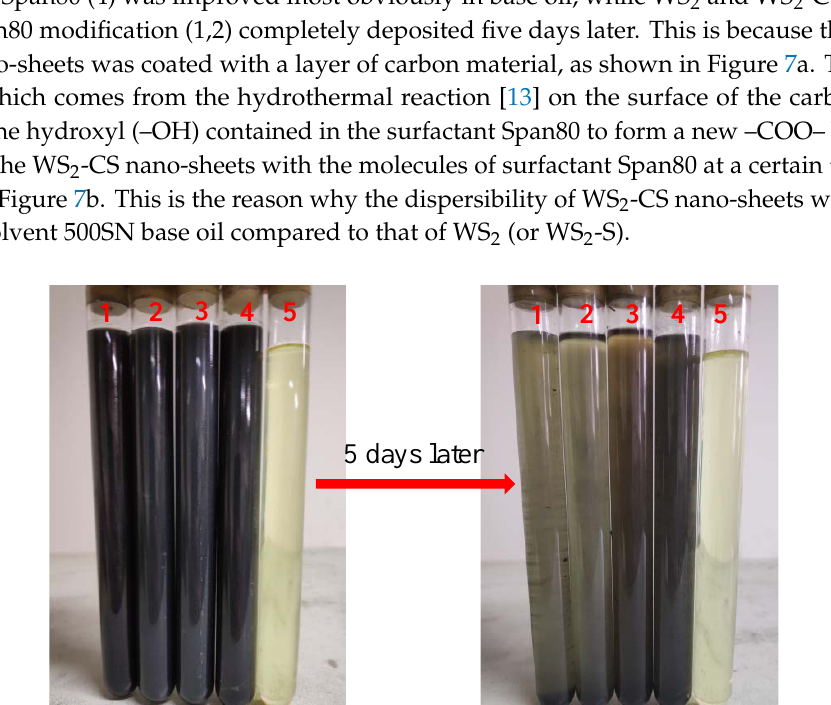
0.5 wt % WS 2 ; ( 2 ) 500SN + 0.5 wt % WS 2 -C; ( 3 ) 500SN + 0.5 wt % WS 2 -S; ( 4 ) 500SN + 0.5 wt % WS 2 -CS, and